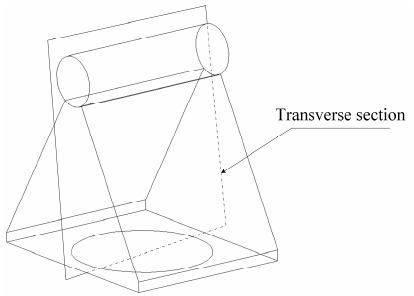
Figure 12. Transverse section diagram of air-cooled unit in column 1 row 4.